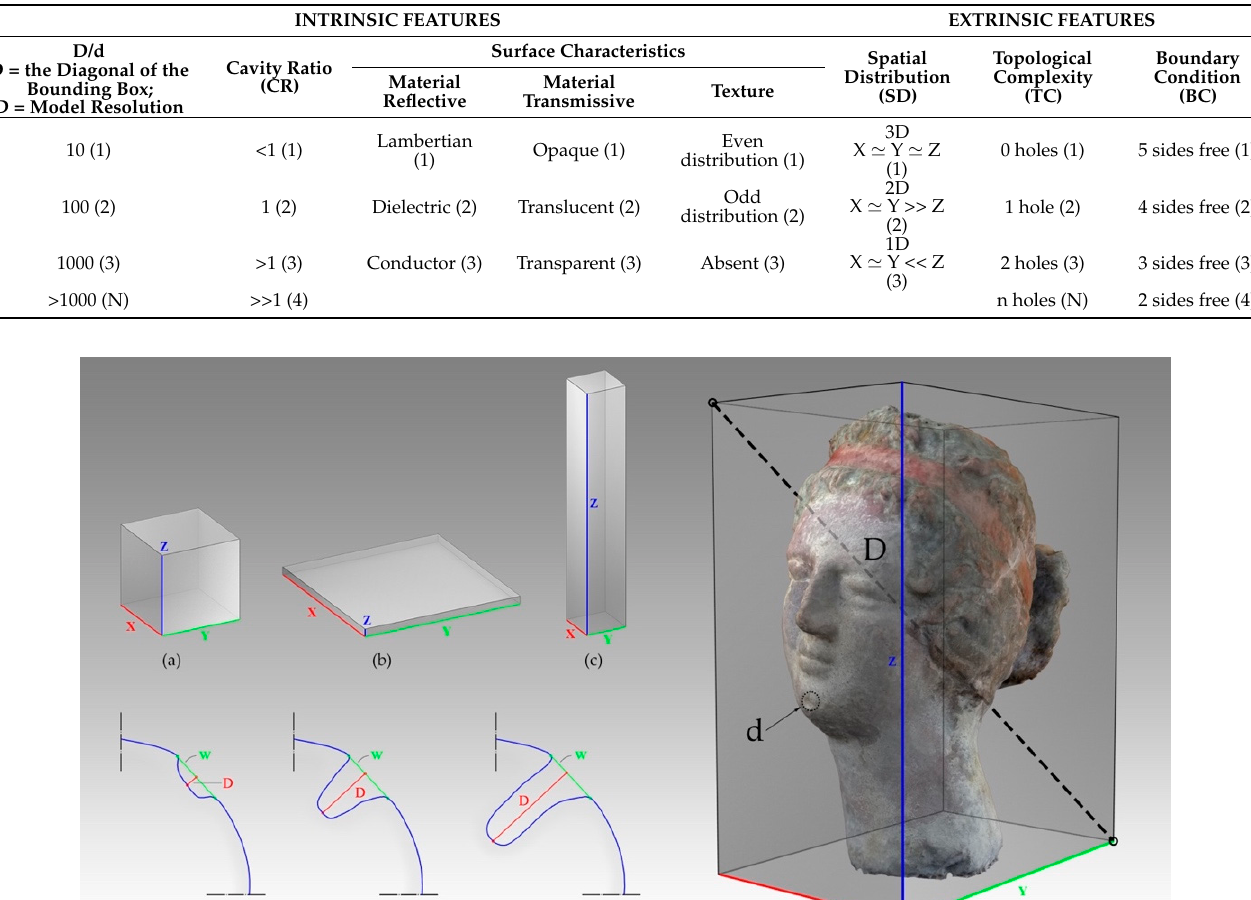
Table 1. Categories of acquisition complexity. Higher scores correspond to a higher complexity level.